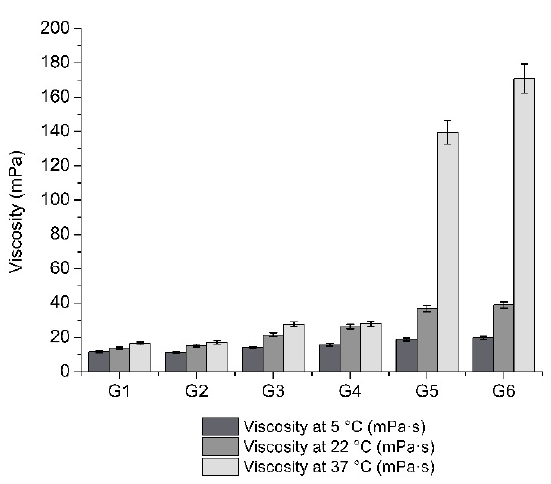
Figure 2. Viscosity parameters of formulations G1–G6 at 5 °C, 22 °C, and 37 °C (mean mPa · s ± SD, n = 3).